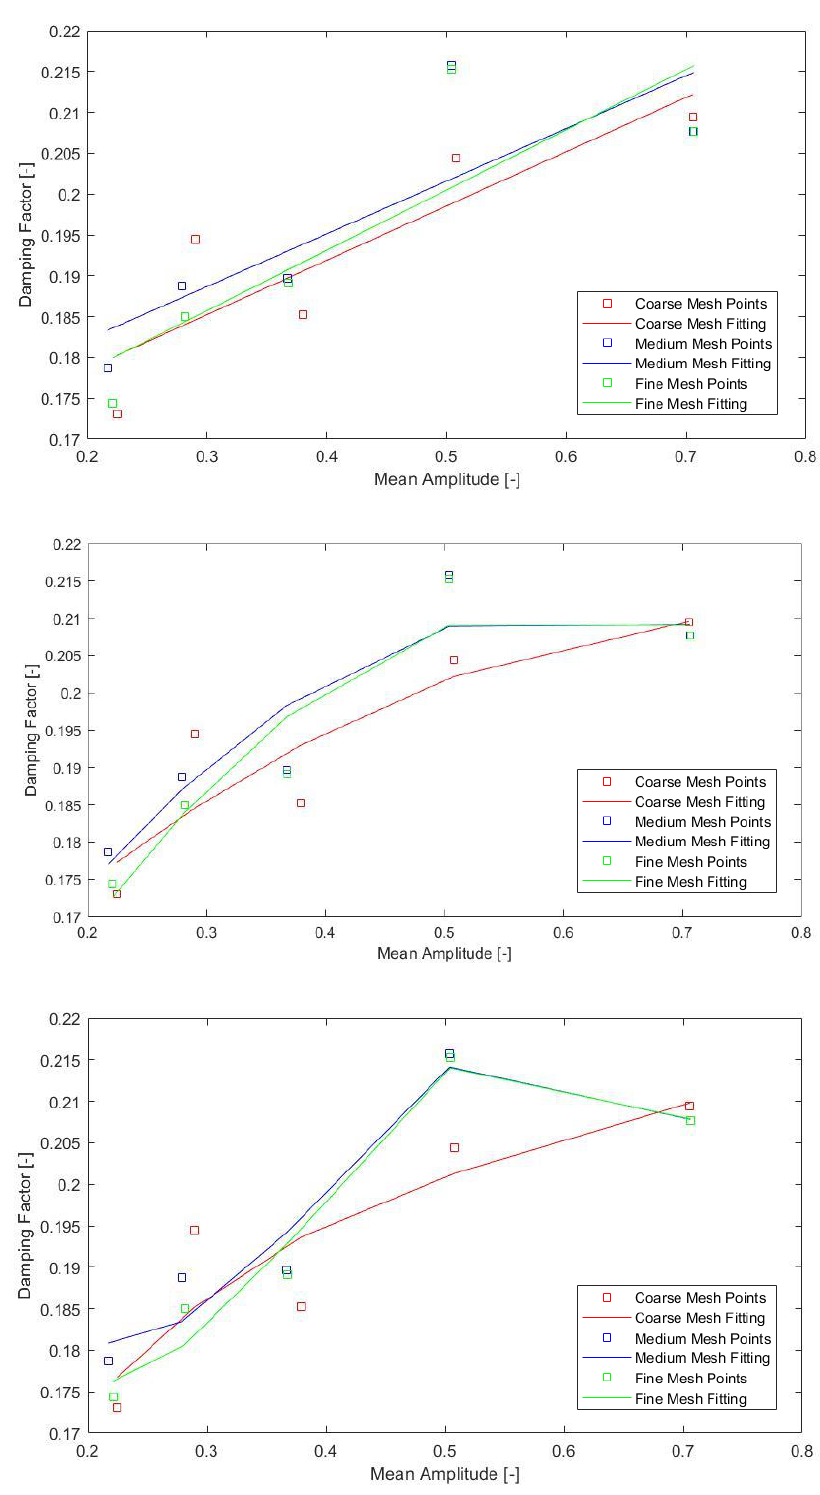
Figure 3. Comparison of the relation of the tendencies used for the case with linear ( up ), quadratic ( mid ) and cubic ( down ) fitting.